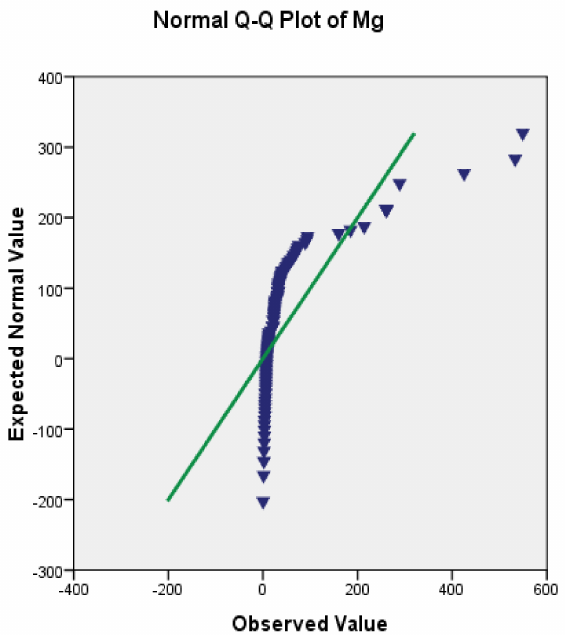
Figure 2. Q-Q plot before log transformation for magnesium.